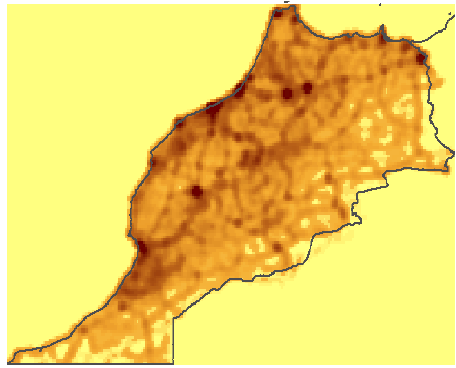
Figure 9. Transportation development index map in Morocco